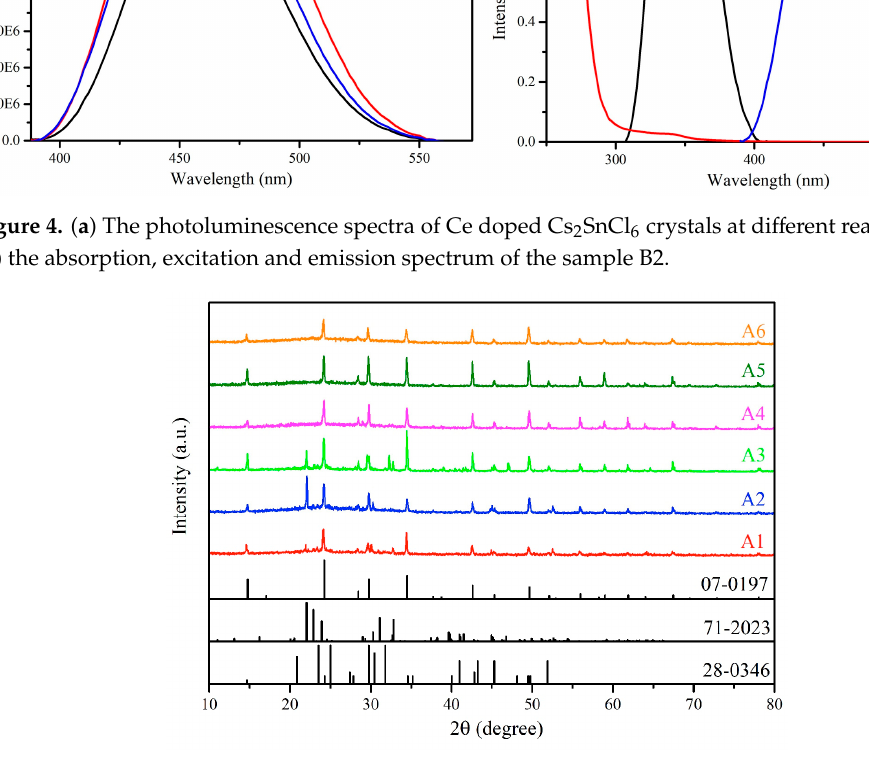
Figure 4. ( a ) The photoluminescence spectra of Ce doped Cs 2 SnCl 6 crystals at different reaction time; ( b ) the absorption, excitation and emission spectrum of the sample B2.